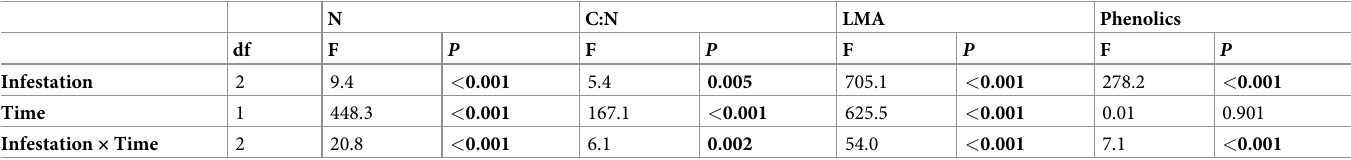
Table 2. F and P values of two-way ANOVA examining the effect of infestation status (Infestation: Control, uninfested; vH13-US and vH13-ISR [averaged response], compatible; GP, incompatible), time of post infestation (Time: Four and twelve days post infestation), and their interaction on relative changes, com- pared with pre-infestation averages, in nitrogen (N), ratio of carbon to nitrogen (C:N), leaf mass per area (LMA) and phenolics.